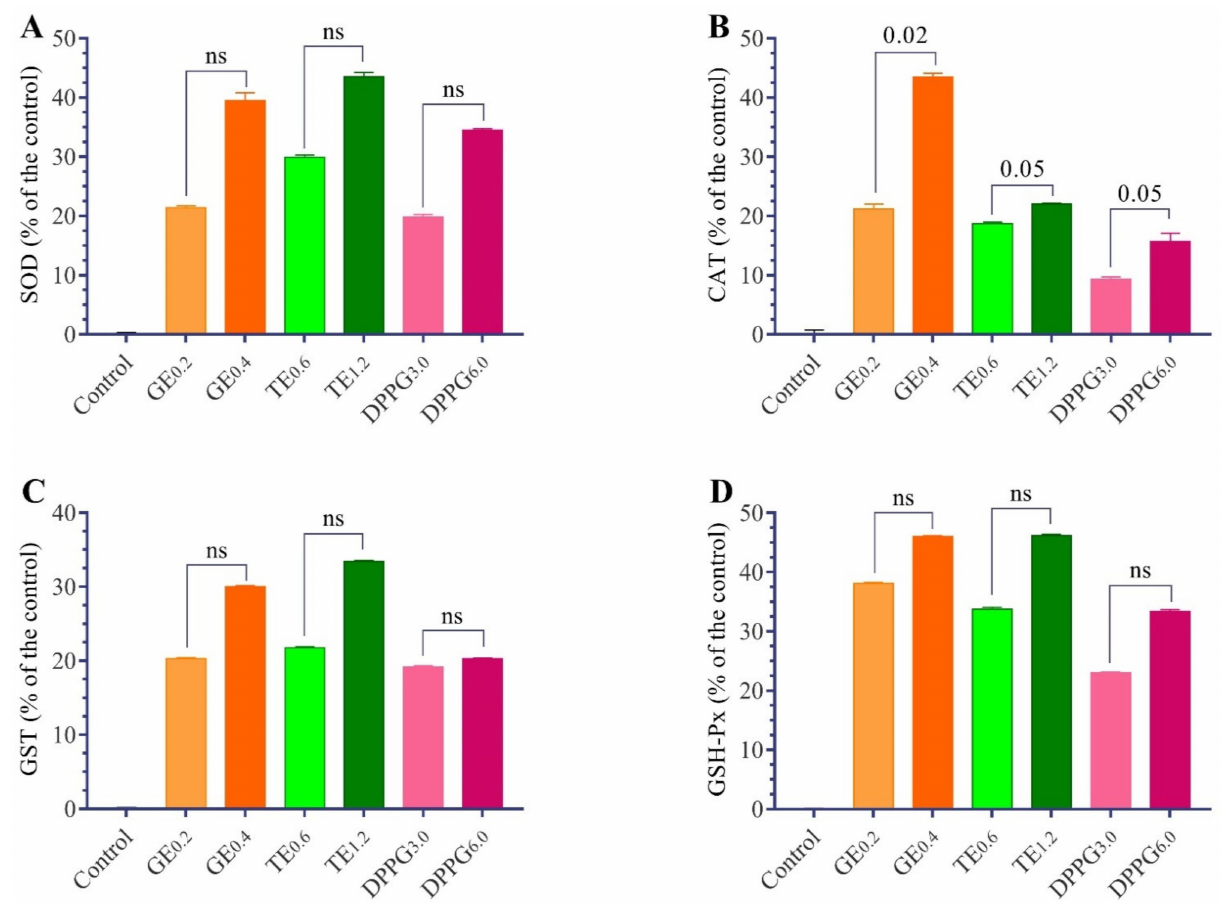
Figure 3. Effect of different antioxidants supplementation (g/kg diet) on changes of superoxide dismutase (SOD; ( A )); catalase (CAT; ( B )); glutathione-S-transferase (GST; ( C )) and glutathione peroxidase (GSH-Px; ( D )) activities as a percent of the control in testes homogenate of Nile